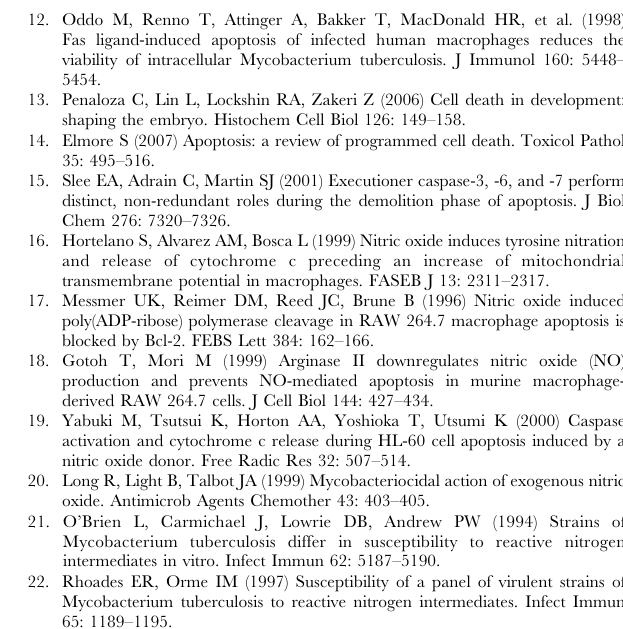
Figure S1 Cell viability is not affected by NMLA or 3-MA. Resting or IFN- c activated (2000 U/ml O/N) BMM W were infected with M. tuberculosis (MOI 1) for 1 h, and subsequently treated with NMLA (1 mM; A) or 3-MA (10 mM; B). Cell viability at 48 h p.i. was determined with the WST-1 cell proliferation assay. Cell viability is determined by the amount of formazan dye produced by metabolically active cells by cleavage of the substrate WST and measured spectrophotometrically at 450 nm. (TIF) Figure S2 IL-4 does not revert IFN- c mediated killing of Mtb. Resting or IFN- c activated (20 U/ml O/N) BMM W were infected with M. tuberculosis (MOI 1) 1 h, and subsequently treated with IL-4 (50 U/ml). To determine mycobacterial survival, macrophages were lysed every 24 h and serial dilutions were plated onto agar plates for CFU determination. Data represent means 6 SD of triplicate cultures from one representative experiment out of three. Statistical analysis was performed by ANOVA (** p , 0.01; *** p ,